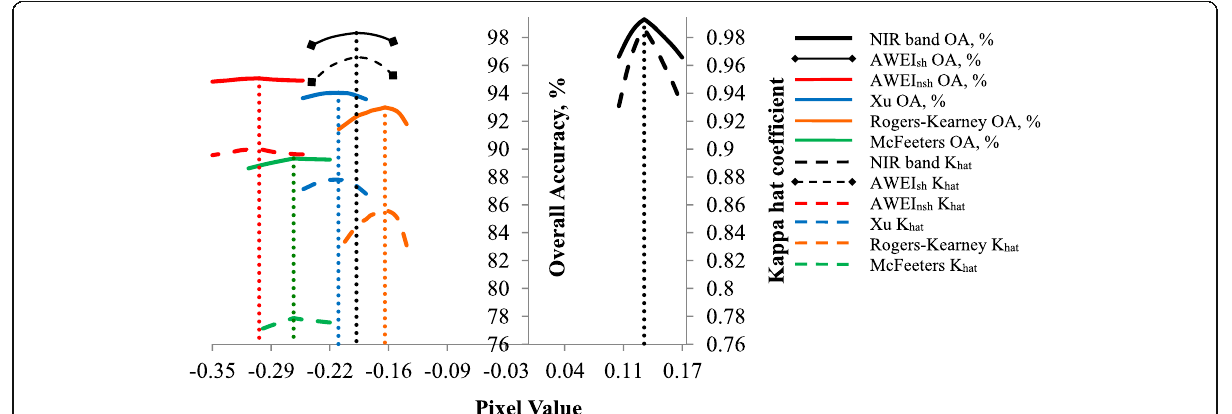
Fig. 9 Optimum Threshold values (the corresponding vertical dotted points) is where the highest values for overall accuracy (OA) and Kappa hat coefficient (K hat ) were